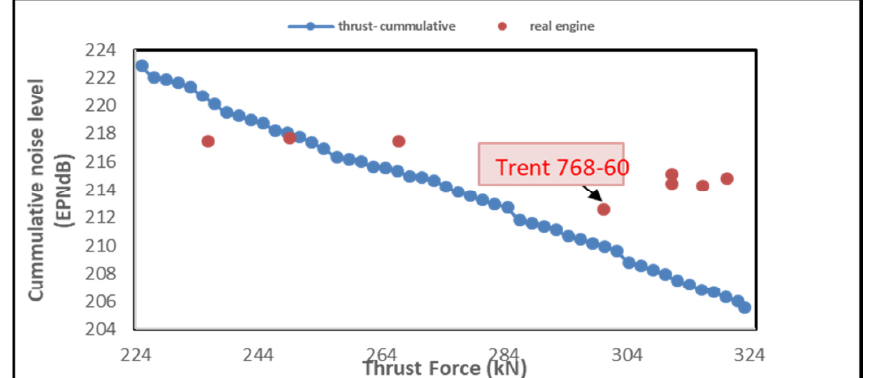
Fig. 4. Trade-0ff curve tow between engine thrust force and cumulative noise level with a real